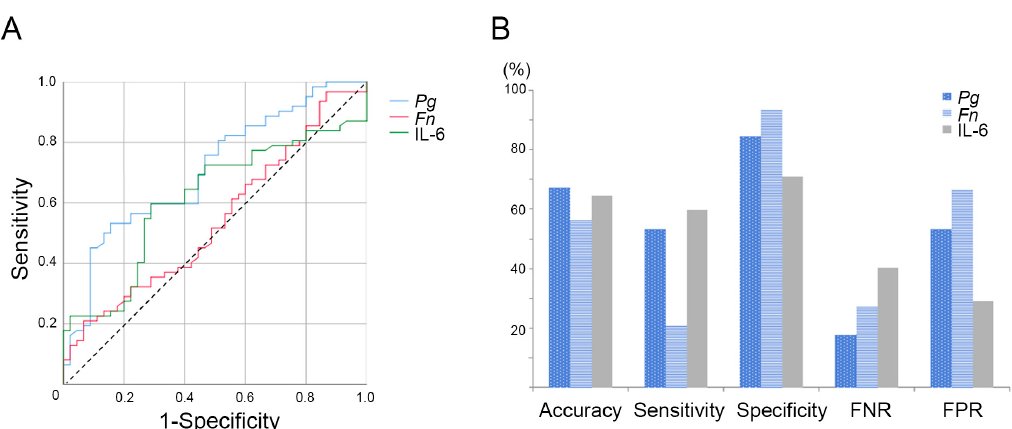
Figure 2. Receiver operating characteristic (ROC) curves ( A ) used for the diagnosis of OSCC patients vs healthy controls ( A ). The AUCs (areas under the ROC curves) are 0.708 for P. gingivalis IgG, 0.543 for F. nucleatum IgG, and 0.613 for serum IL-6. ( B ) Clinical performances of P. gingivalis IgG, F. nucleatum IgG, and serum IL-6 as a diagnostic marker for discrimination of OSCC and non-OSCC controls in terms of accuracy, sensitivity, specificity, false negative rate (FNR), false positive rate (FPR). The correlations between the serum levels of P. gingivalis and F. nucleatum IgG and IL ‐ 6 were